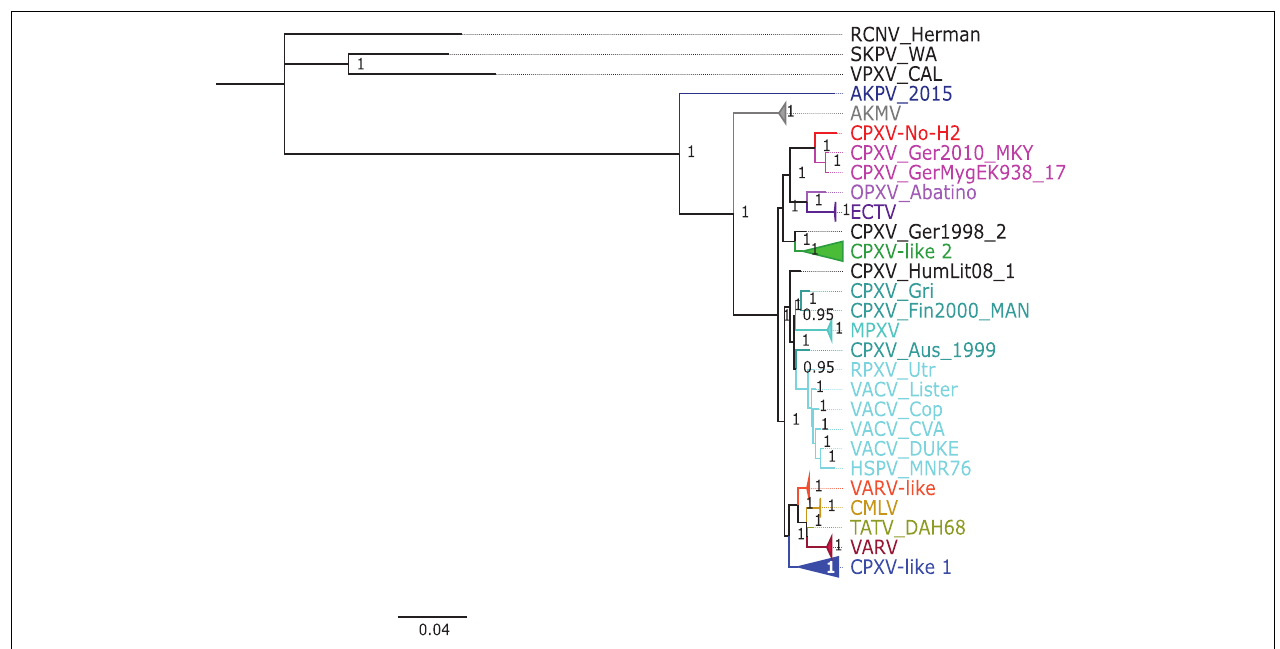
FIGURE 4 | Bayesian inference phylogenetic tree based on 134 orthopoxvirus orthologous genes. Posterior probabilities are shown on the right side of each node, and only posterior probabilities above 0.6 are shown. The cowpox virus (CPXV) strains were grouped into different clades: CPXV-like 1, CPXV-like 2, and VARV-like (Franke et al., 2017). The scale bar represents the expected substitutions per